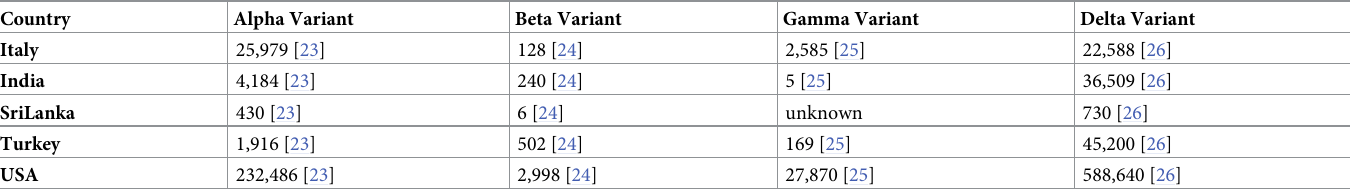
Table 1. Number of COVID-19 infections by October 18, 2021, classified by variants and countries. Country